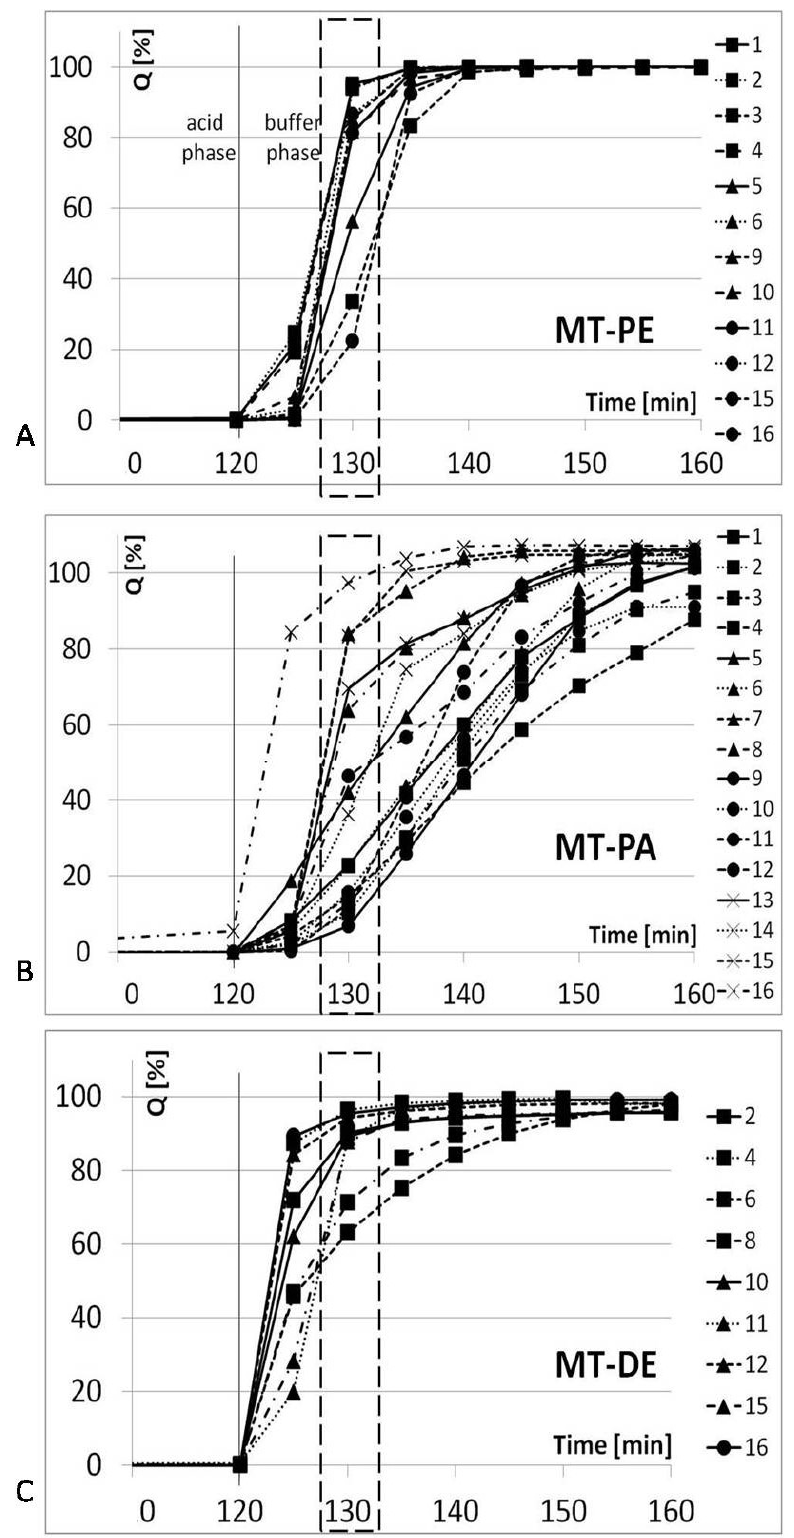
Figure 2. Dissolution profiles of enteric-coated MTs with pantoprazole (( A )—MT-PE; ( B )—MT-PA) and diclofenac (( C )—MT-DE).